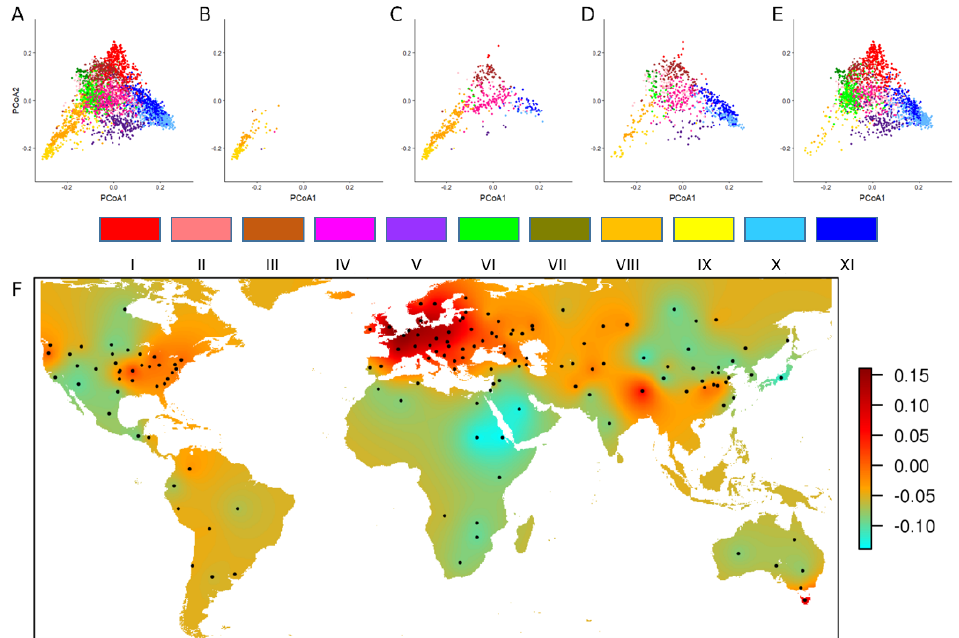
Figure 2. Temporal evolution of worldwide genetic diversity. PCoA calculated with 8741 haplotypes ( A ) on 4403 accessions, ( B ) on 139 Southeast Asia and Indian Peninsula landraces, ( C ) on 632 landraces, ( D ) on 947 traditional cultivars, and ( E ) on 2210 modern varieties. The different colors correspond to the 11 groups defined with a phylogenetic analysis [16]. Group I: modern lines, Southeast Europe; Group II: Northwest Europe, North America; Group III: North America, Southeast Europe; Group IV: Northwest Mediterranean; Group V: modern lines, China, Italy; Group VI: modern lines, CIMMYT, Northwest China; Group VII: modern lines, Canada, China, USA; Group VIII: Southeast Asia, India, Pakistan; Group IX: China, Japan; Group X: modern lines, France, UK; Group XI: France, Germany. ( F ) Geographical projection of the first axis of the PCoA for 2210 modern varieties.